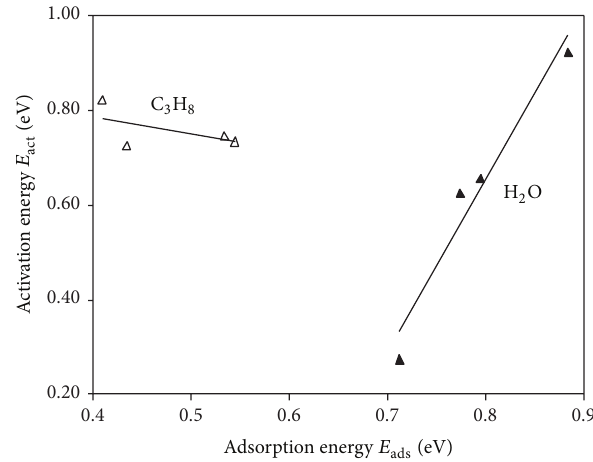
(eV), for the act Figure 10: Activation energy, 𝐸 (eV), versus adsorption energy, act 𝐸 (eV), for propane dehydrogenation, “open triangles,” and for ads water dissociation, “solid